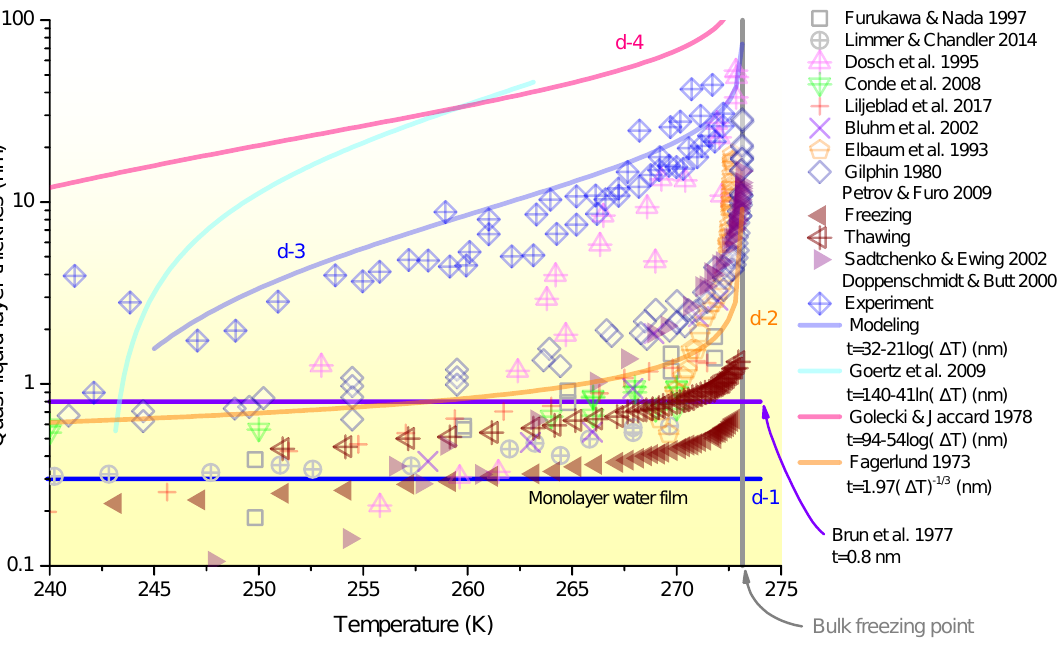
Figure 2. QLL thickness data from the literature [6–12,19,29,31–36]. The QLL thickness data reported in Furukawa and Nada (1997) [11], Conde et al. (2008) [10], and Limmer and Chandler (2014) [7] were obtained by molecular dynamic simulations; those in Elbaum et al. (1993) by interference microscopy; those in Dosch et al. (1995) [12] by glancing-angle X-ray scattering; those in Gilpin (1980) [36] by theoretical calculation; those in Doppenschmidt and Butt (2000) [6] by atomic force microscopy; those in Bluhm et al. (2002) [8] by photoelectron spectroscopy; those in Sadtchenko and Ewing (2002) [34] by infrared spectroscopy; those in Petrov and Furo (2009) [19] by thermodynamic estimations; and those in Liljeblad et al. (2017) [9] by total internal reflection Raman, vibrational sum frequency, and NMR spectroscopies. The t − T line reported in Goertz et al. (2009) [33] was regressed from the experimental data measured by interfacial force microscopy and that in Brun et al. (1973) [32] by differential scanning calorimetry. The t − T curves of d-1, d-2, d-3, and d-4 are representatively selected for unraveling the influences of QLL on freezing of porous materials; see Table